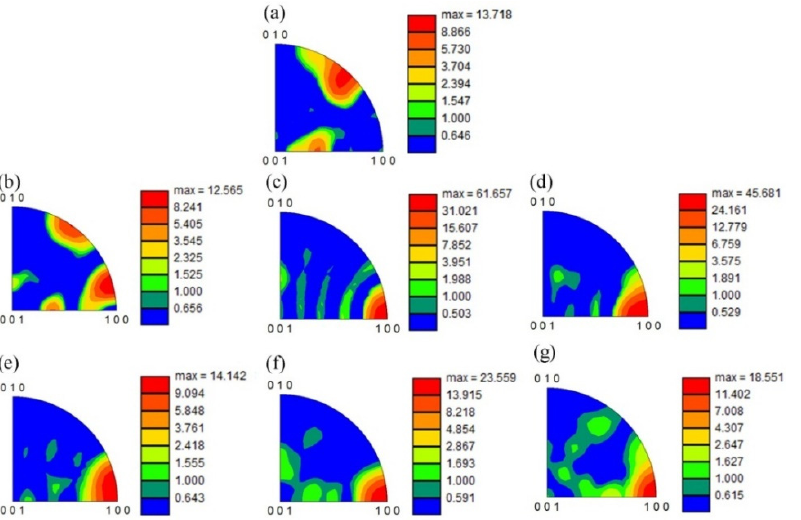
Figure 9. Inverse Pole Figure of O phase in normal direction (ND) of the spun workpiece formed at different passes: ( a ) initial welded tube, ( b ) pass 1st, ( c ) pass 2nd, ( d ) pass 3rd, ( e ) pass 4th, ( f ) pass 5th, ( g ) pass 6th. Table 3. Schmid factors of the two main slip systems of B2 phase in axial and tangential direction. Slip